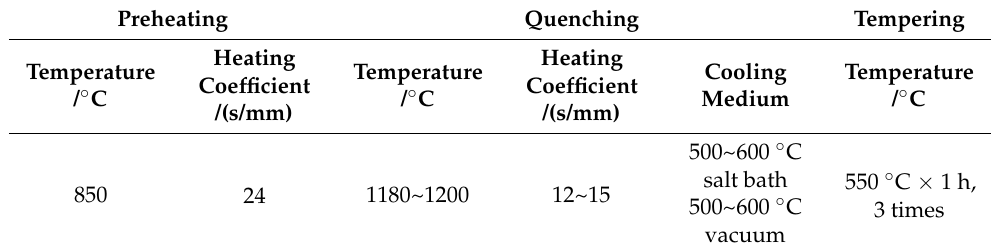
Table 1. The processing parameters of two heat treatments.